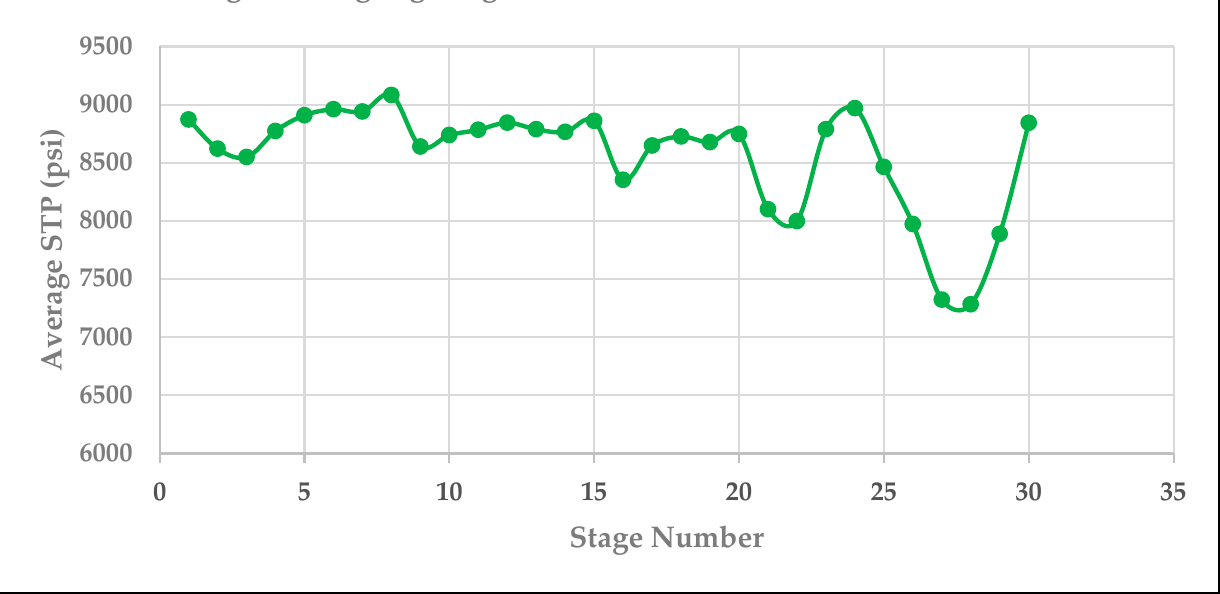
Figure 6. Plot showing trend in average STP for well 3.